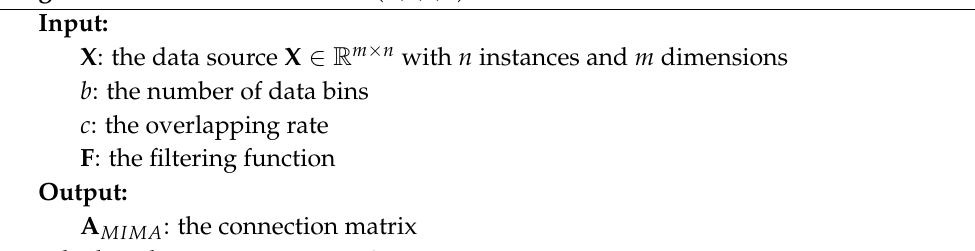
Algorithm A4: MIMA-MAPPER ( X , b , c , F